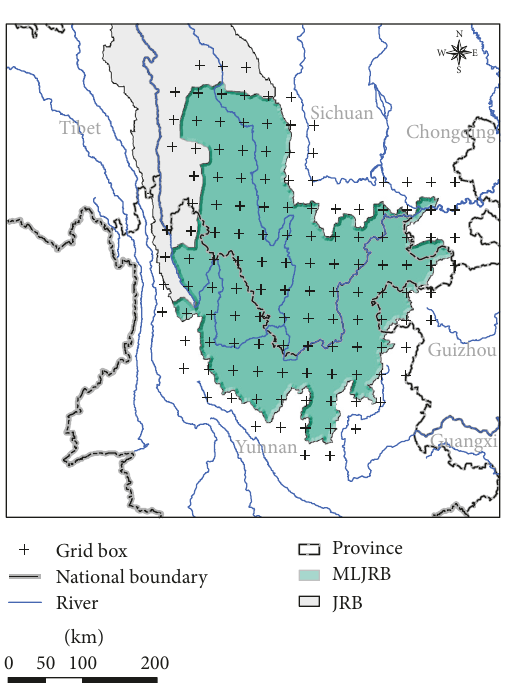
Figure 5: Grid boxes selected in